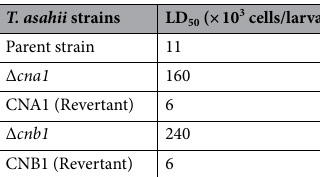
Table 1. The LD 50 values of T. asahii